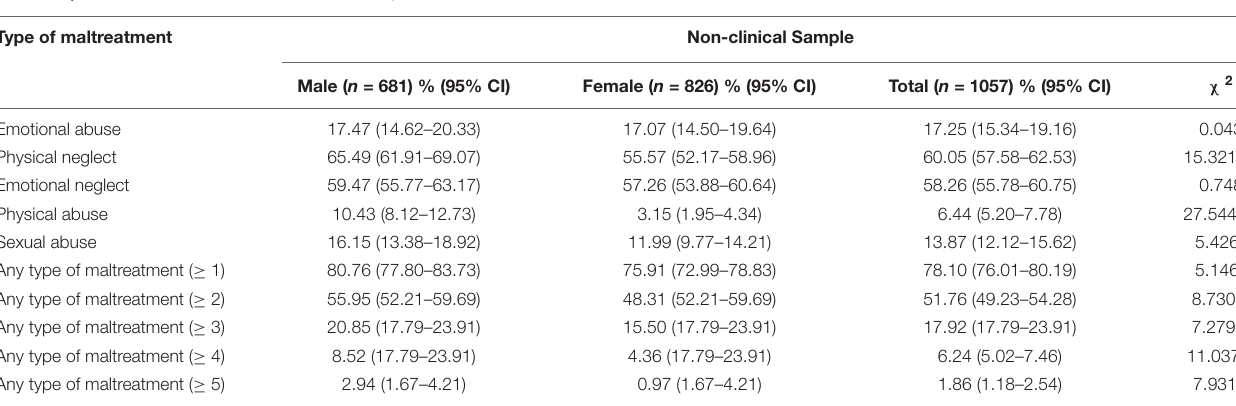
TABLE 3 | Prevalence of CTQ-SF in non-clinical